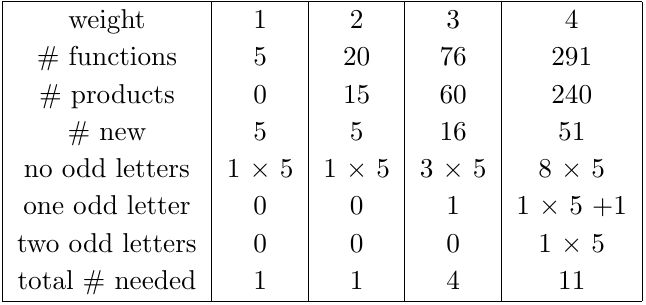
Table 4 . Classi(cid:12)cation of pentagon functions (without v 1 + v 2 type letters) up to weight